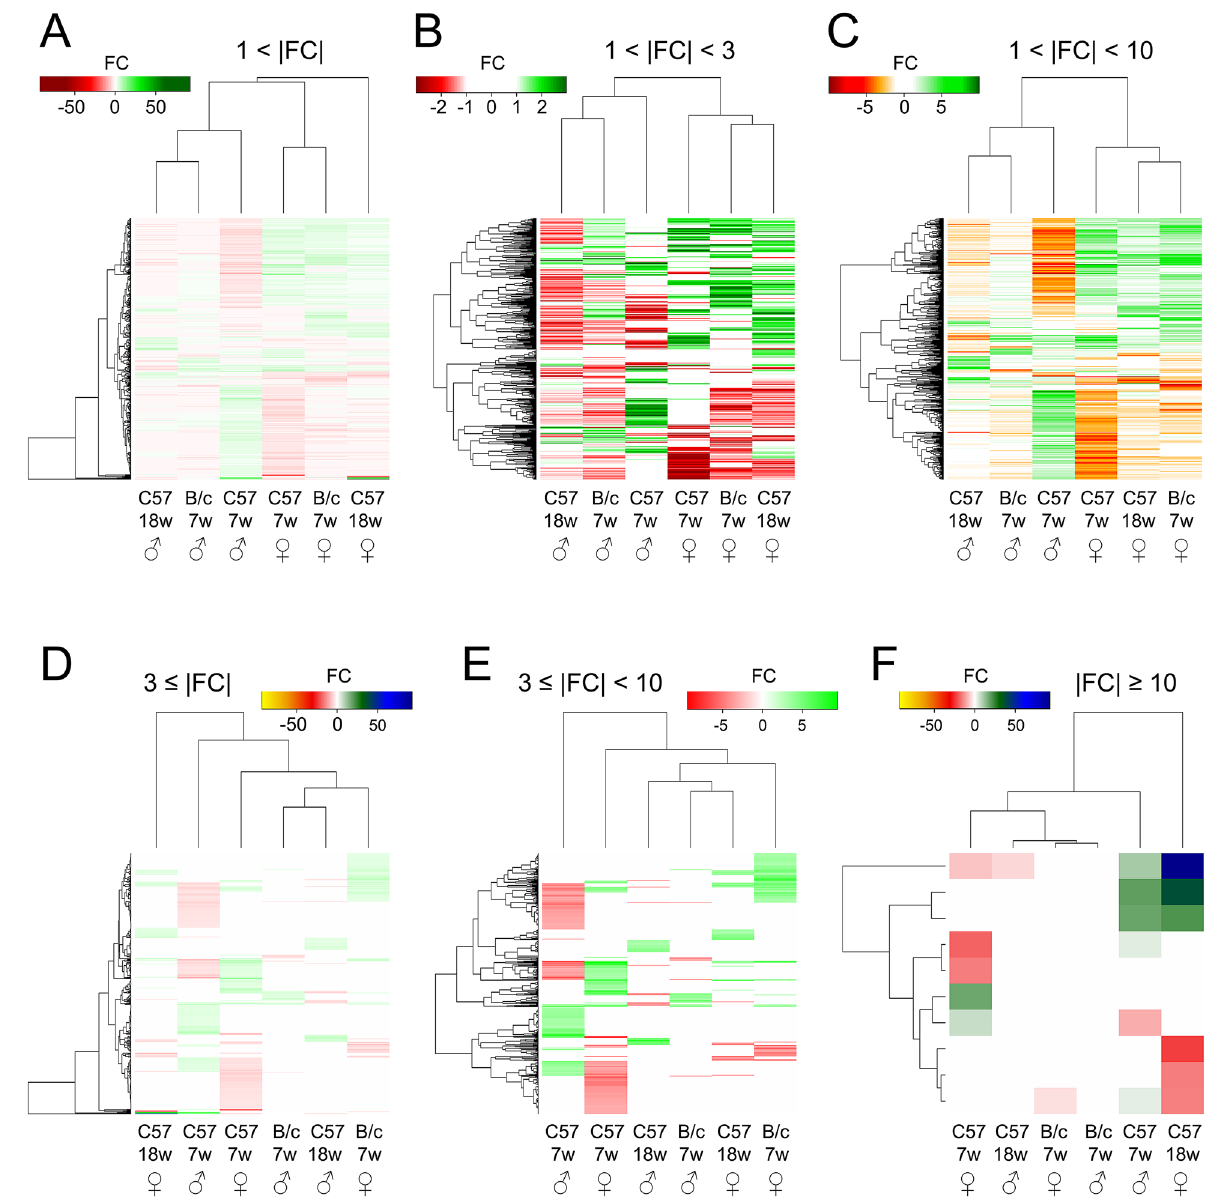
Figure 3. Relative distance between age, sex and strain groups in dependence of fold change intervals. Hierarchical cluster analysis of filtered proteins according to fold (FC) intervals of differentially abundant proteins in blood plasma 24 h after 0.5 Gy total body irradiation. Cutoff FC values were used to differentiate between the impact on distance of proteins with low (1 <|FC|< 3), high (3 ≤|FC|< 10), and very-high (|FC|≥ 10) abundance change: entire filtered cohort ( A ), low abundance change ( B ), low and high abundance change ( C ), high-to-very-high abundance change ( D ), high abundance change only ( E ), very-high abundance change only ( F ). Green, overabundance; red, underabundance; C57, C57BL/6 N mice; B/c, BALB/c nude mice; 7w, 7-weeks- old (juvenile) mice; 18w, 18-weeks-old (adult) mice; ♀ , female; ♂ , male. Please note that presented data is normalized to respective unirradiated control